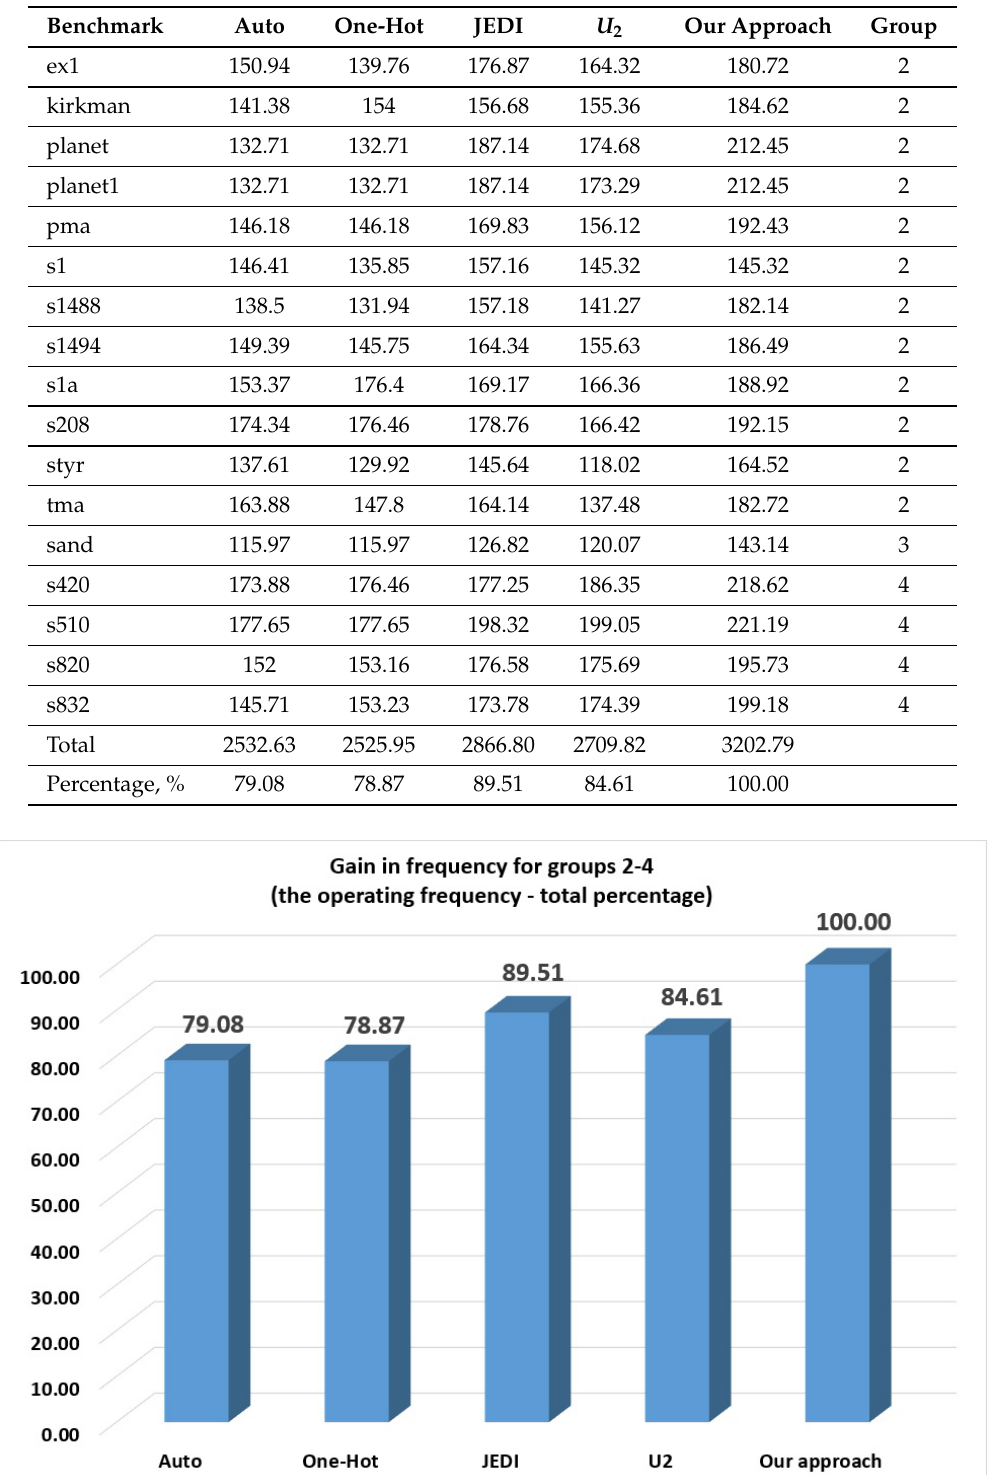
Table 14. Gain in frequency for groups 2–4 (the operating frequency).